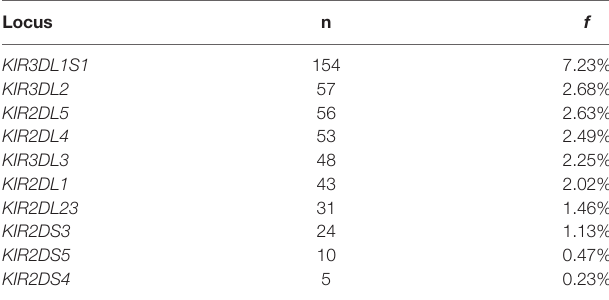
TABLE 1 | Large proportion of individuals carrying possible novel